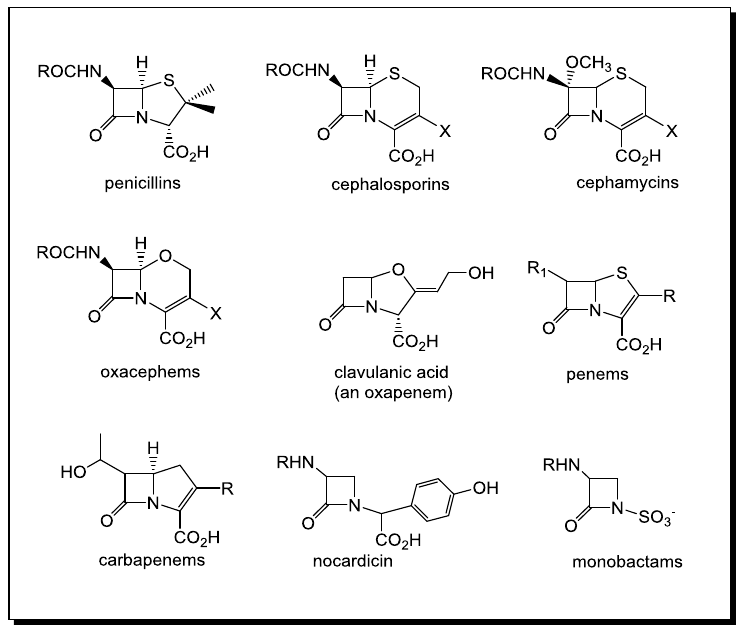
Figure 1. Clinically relevant β-lactam